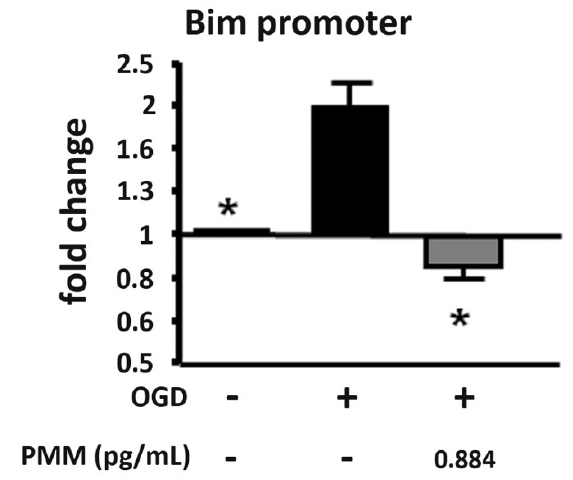
Figure 3. Pre-treatment with PMM reduces H3 histone acetylation at the Bim promoter in neurons subjected to OGD. ChIP assay in cortical neurons exposed to OGD. Cells were pre-treated with the PMM at DIV 7. At DIV 11, cells were exposed to 3 h of OGD and then maintained in recovery medium for 2 h. The mixture was renewed at every change of media. The ChIP assay was performed at